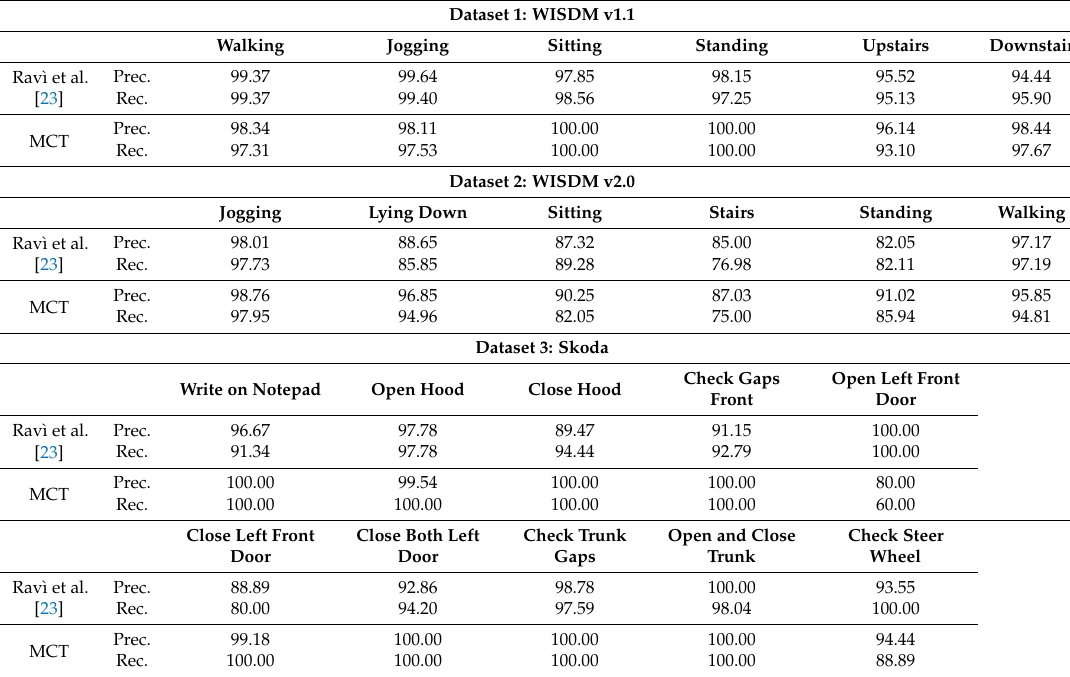
Table 6. Precision (%) and recall (%) obtained by the proposed multichannel (MCT) method and existing study [23] in three public